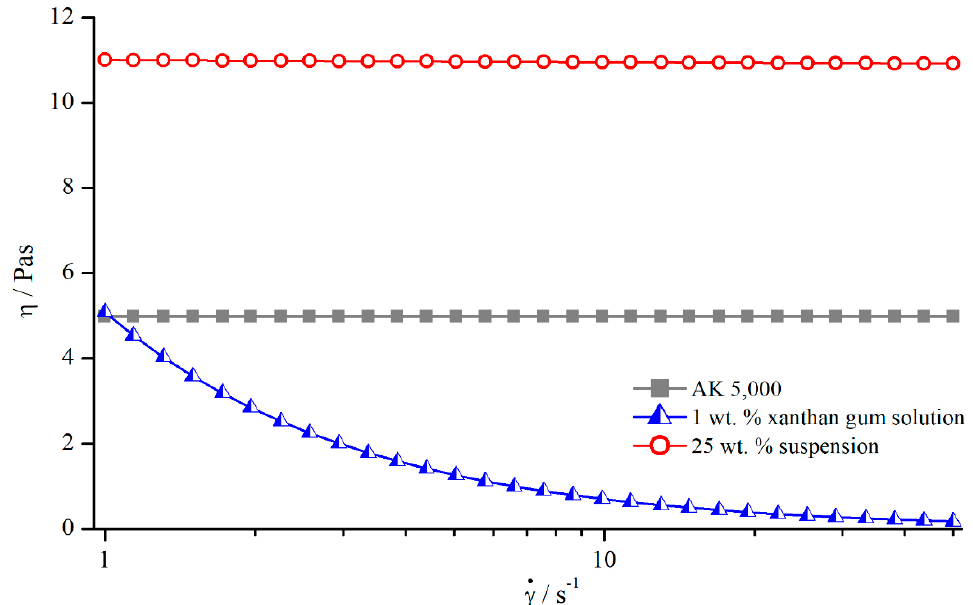
Figure 21. Flow curves of silicon oil AK 5000, 1 wt. % xanthan gum solution, and 25 wt. % suspension, measured with reference system.